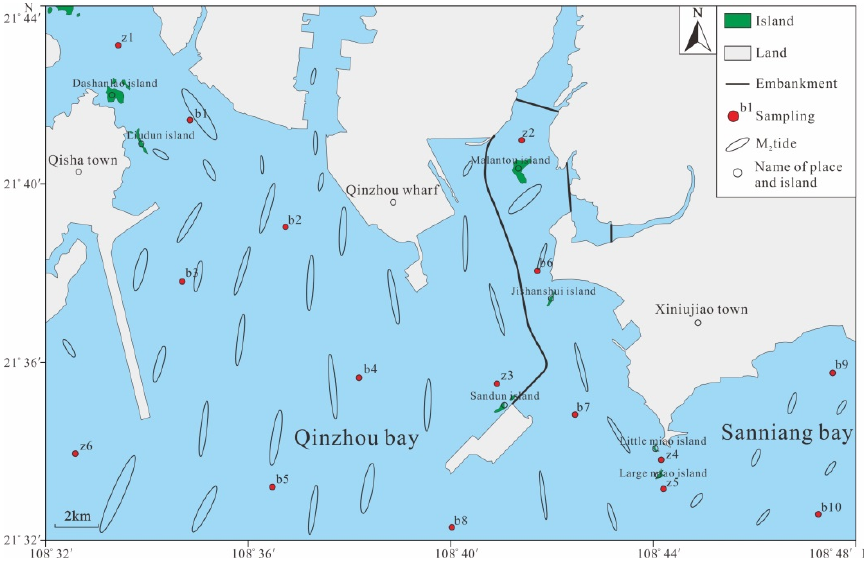
Figure 2. Distribution of sampling sites in the research area. [30].